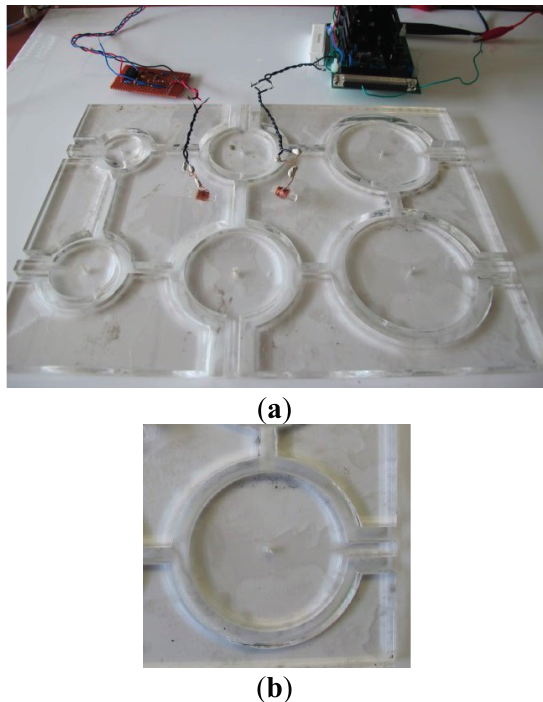
Figure 17. Experimental setup: ( a ) Tube experiment set-up; ( b ) Single arc.